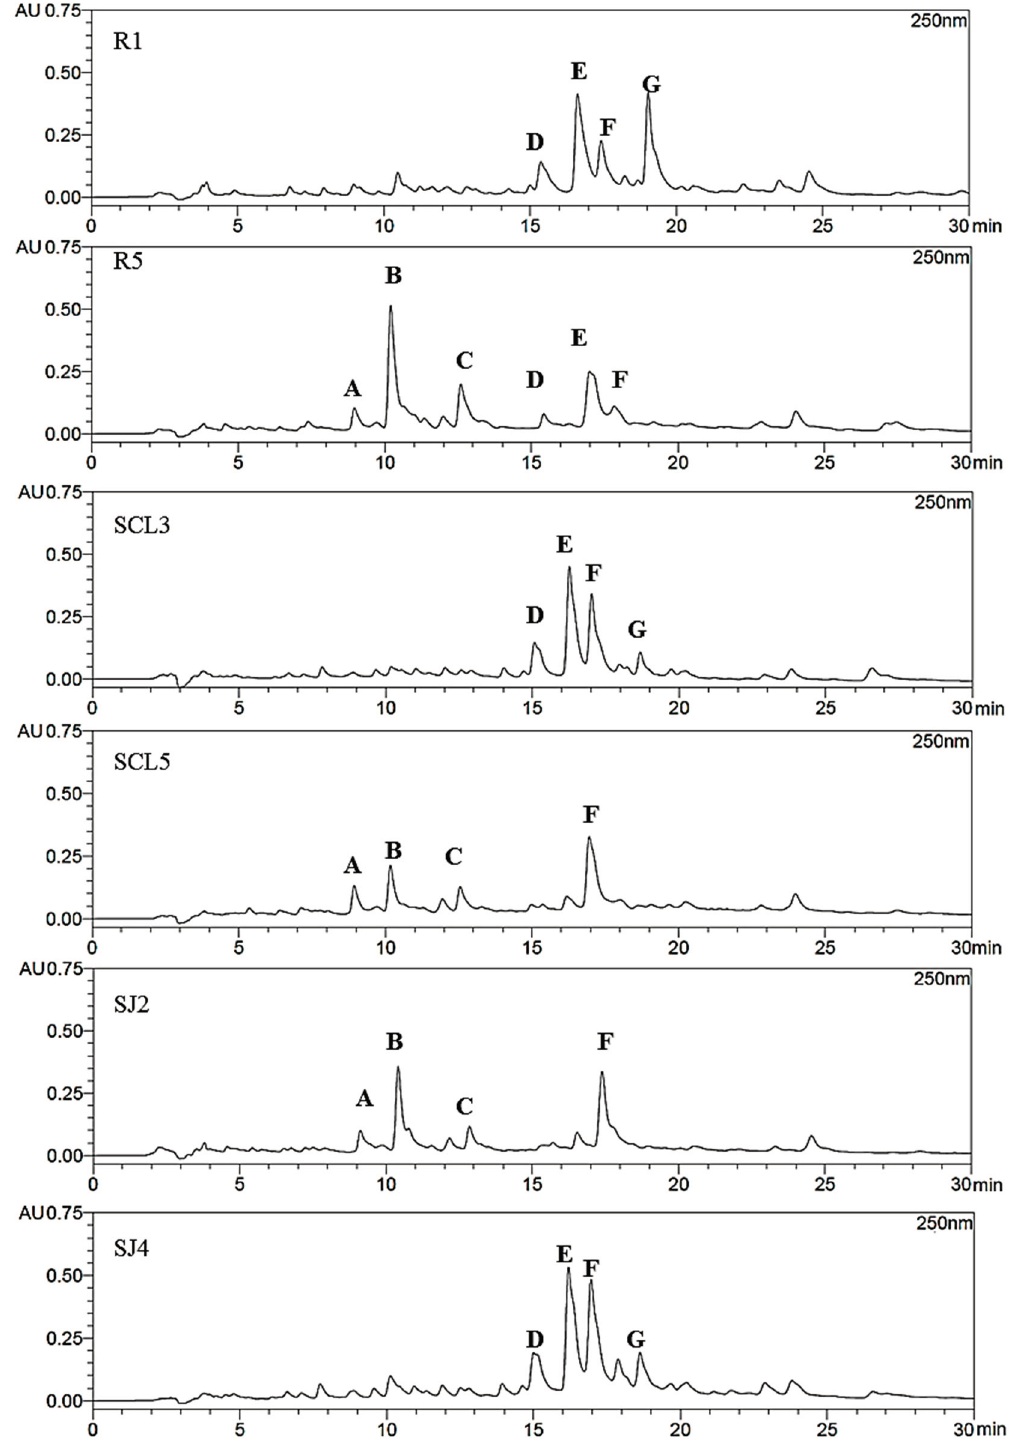
Figure 2. HPLC chromatograms of the most and less active antimicrobial propolis samples from the Región del Maule, Chile. Andean slopes: R1: Romeral 1; R5: Romeral 5; Central valley: SCL3: San Clemente 3; SCL5: San Clemente 5; Coastal area: SJ: San Javier 2; SJ4: San Javier 4. Detection: UV, 250 nm. A: flavonol; B: simple phenolic; C: caffeic acid derivative; D: flavone and dihydroflavonol; F: flavonol; G: